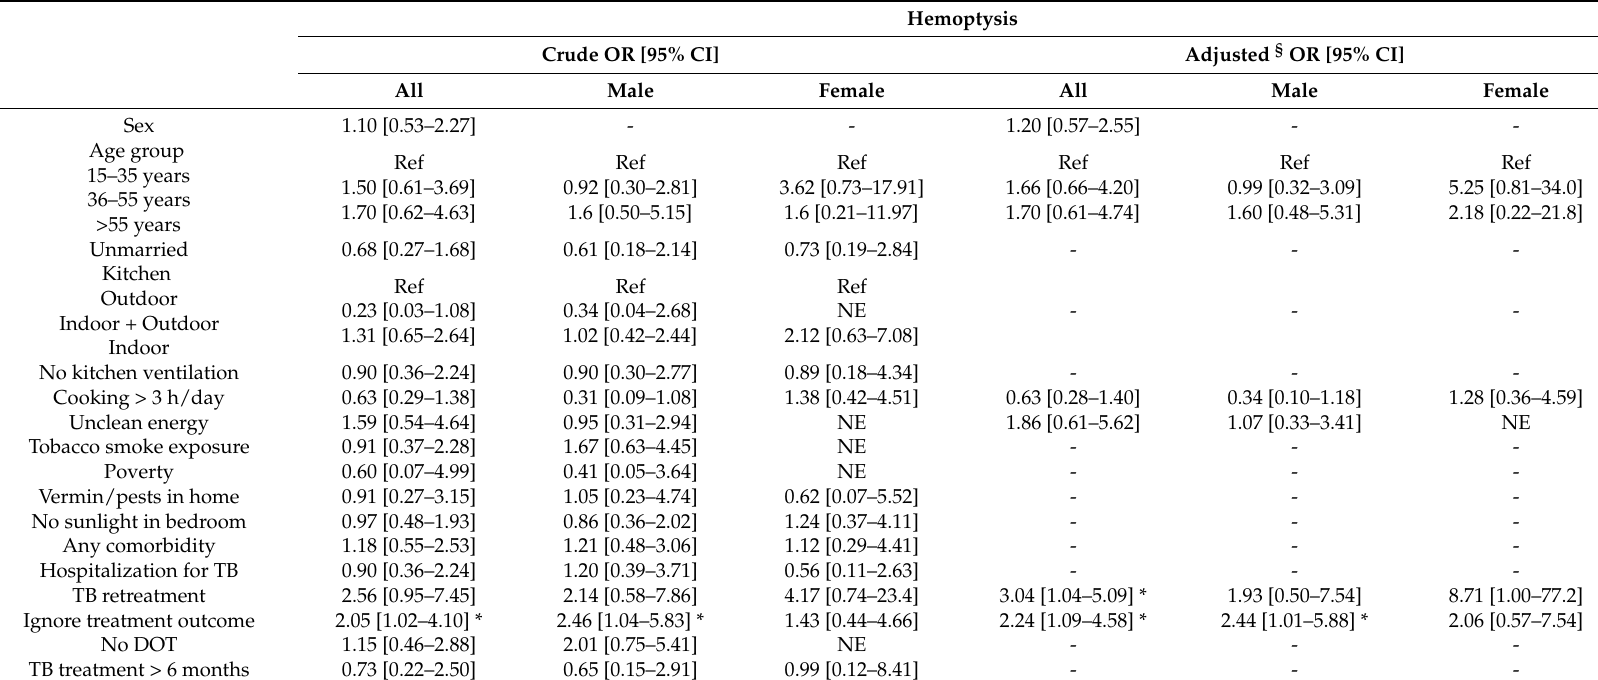
Table 4. Crude and adjusted effects of HAP and other predictors on hemoptysis among survivors of pulmonary TB, overall and by